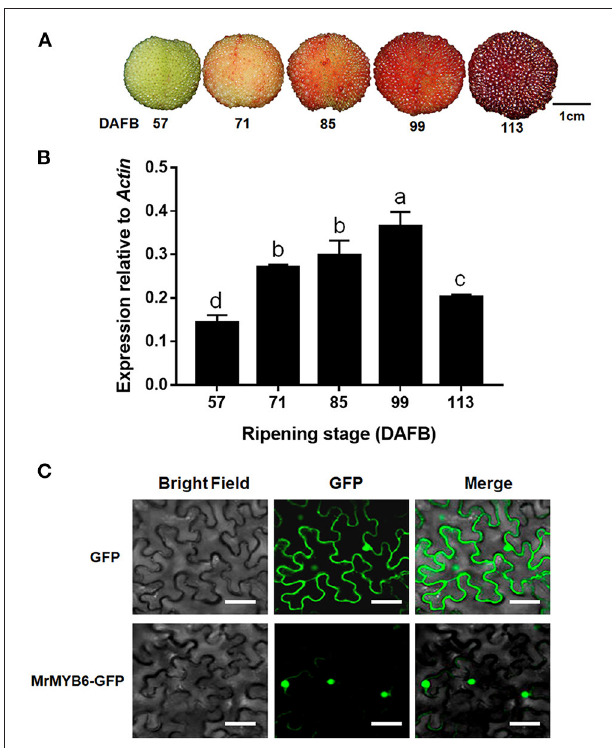
FIGURE 1 | MrMYB6 expression pattern during bayberry fruit development. (A) The bayberry fruits at 57, 71, 85, 99, and 113 days after full bloom (DAFB) used in this study. Scale bar represents 1cm. (B) Expression levels of MrMYB6 at different stages. The data were normalized to the MrACT expression level. Error bars indicate the mean ± SE of three replicate reactions. Letters (a, b, c, and d) represent significant difference between wild-type and transgenic plants according to the Duncan’s multiple range test ( P < 0.05). (C) Subcellular localization of MrMYB6 in tobacco leaf epidermal cells. Scale bar represents 50 µ